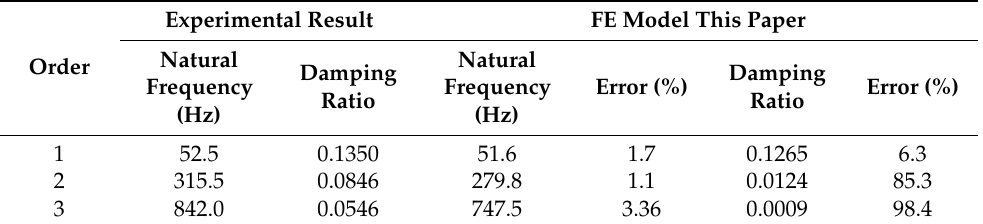
Table 2. Comparison of experimental results and FE calculations.